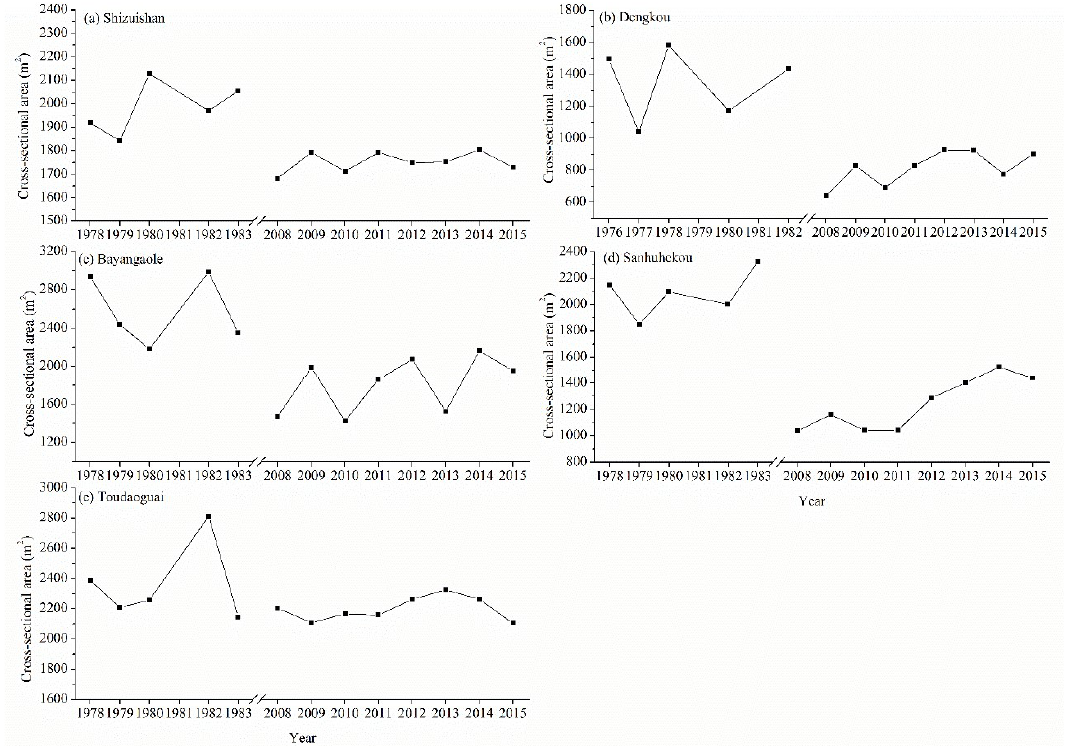
Figure 6. Variations in the bankfull cross-sectional area at the five stations before the ice jam flooding seasons: ( a ) Shizuishan station; ( b ) Dengkou station; ( c ) Bayangaole station; ( d ) Sanhuhekou station; and ( e ) Toudaoguai station.